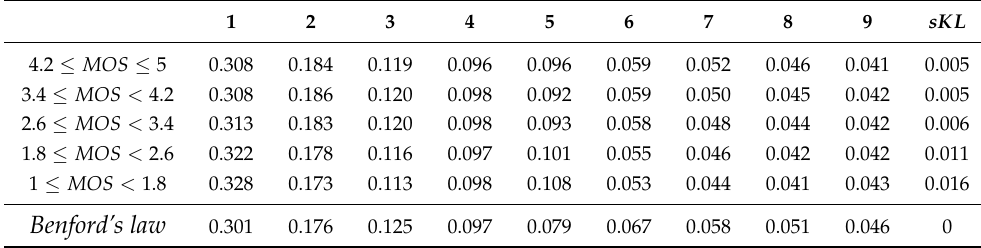
Table 2. Mean FDD of Y directional gradient magnitudes in KoNViD-1k [22] with respect to different MOS intervals. In KoNViD-1k [22], the lowest possible video quality is represented by MOS = 1.0, while MOS = 5.0 stands for the highest possible video quality. In the last column, the symmetric Kullback–Leibler ( sKL ) divergences between the actual FDD and the Benford law distribution are